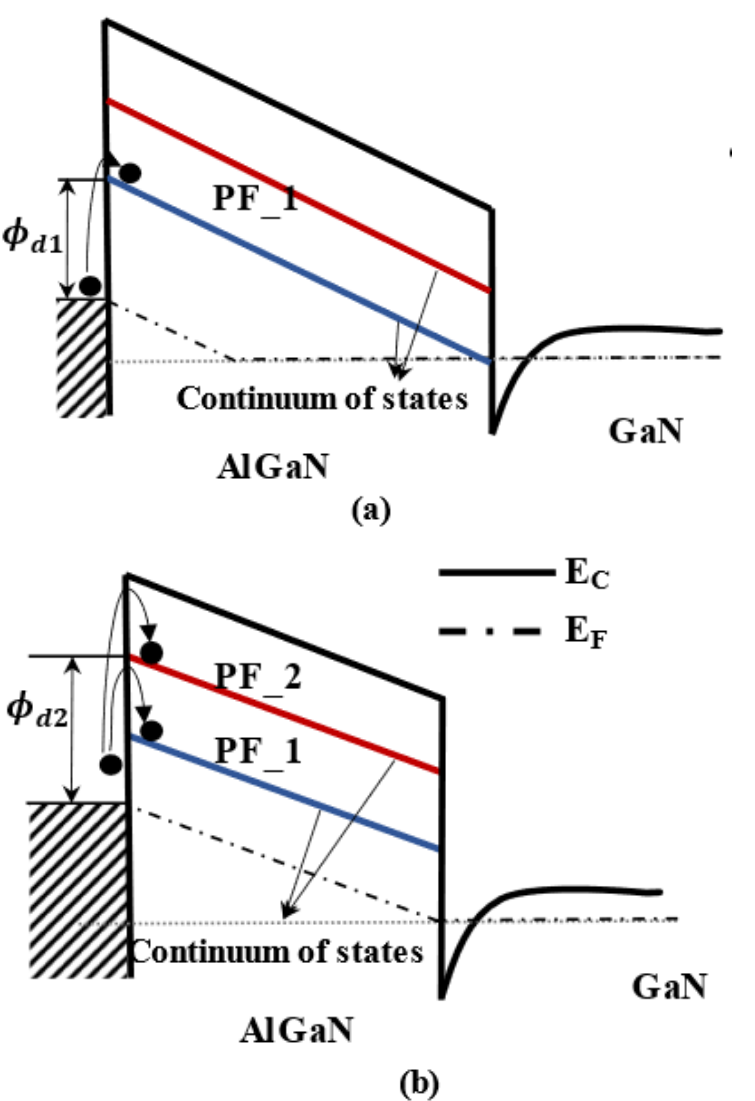
Figure 4. Conduction band edge diagrams of AlGaN/GaN HEMT under reverse gate voltage show- ing PF emissions via ( a ) a V III -decorated dislocation state and ( b ) both a V III -decorated dislocation state and a pure dislocation state.